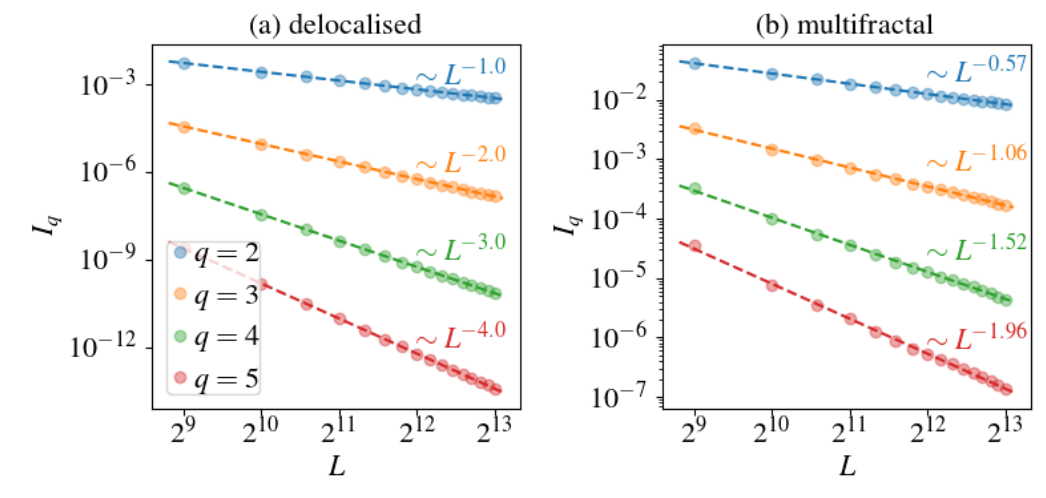
Figure 3: Extraction of τ . Linear fit of log I versus log L for representative delocalised (a) q q and multifractal states (b). The circles show numerical data and the dashed lines show linear = q − 1 for the delocalised states fits. The exponents mentioned in the plot suggest that τ q ≈ D ( q − 1 ) with D (cid:39) 1 / 2 for the multifractal and τ q